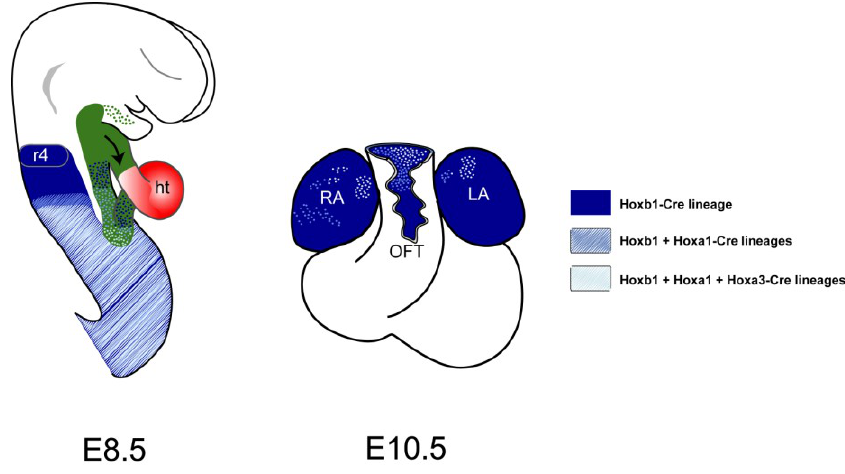
Figure 3. Cardiac contributions of Hox -expressing cells in the second heart field (SHF). Genetic lineage analysis was performed using Hoxb1 IRES-Cre , Hoxa1-EnhIII-Cre , Hoxa3 IRES-Cre and R26R-lacZ lines. X-gal labeled cells are shown in blue. The location of the SHF is shown in green. At 8.5, Hoxb1 - , Hoxa1 - and Hoxa3 -expressing cells identify distinct sub-domains along the anteroposterior axis in the SHF. At E10.5, Hoxb1 - , Hoxa1 - and Hoxa3 -descendants contribute to both atria and the inferior wall of the outflow tract (OFT). Interestingly, descends of Hoxb1 -expressing cells contribute to the proximal OFT, while Hoxa1 and Hoxa3 descendants appear more distally. ht, heart tube; LA, left atria; RA, right atria, r4, rhombomere